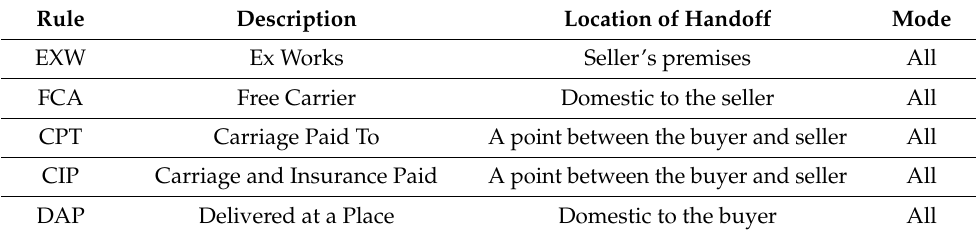
Table 1. Incoterms ® Rules Description, Modes and